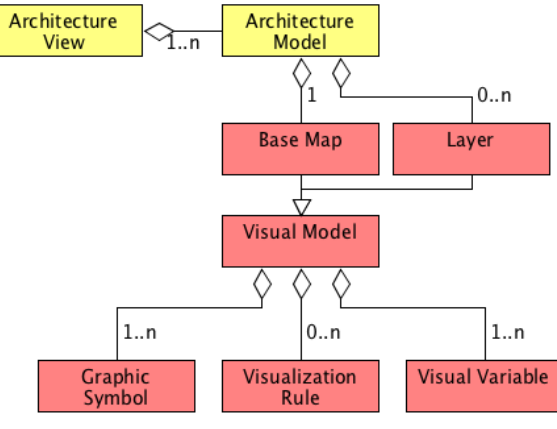
Figure 2. Clarification of the Architecture View [2] through software cartography concepts [7],